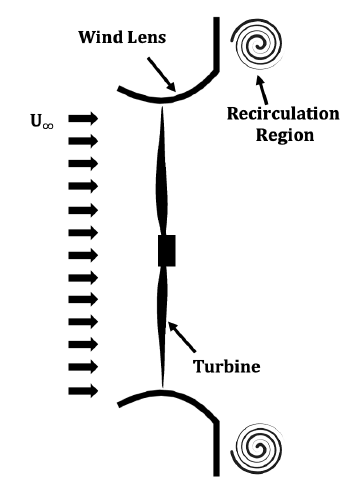
Figure 1. Schematic of a lensed